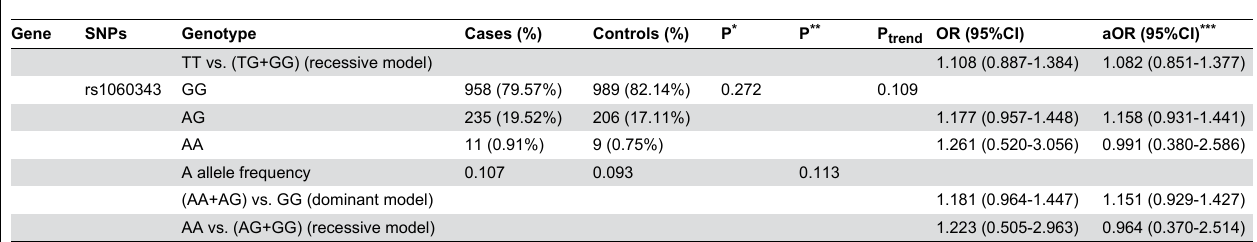
** Two-sided chi-square test for difference in frequency distribution of alleles between cases and controls. *** Adjusted for age, BMI, age at menarche, age at first full-term pregnancy, menopause status, and family history of cancer in first-degree relatives. Bold values indicate a statistical significance at 0.05 level.